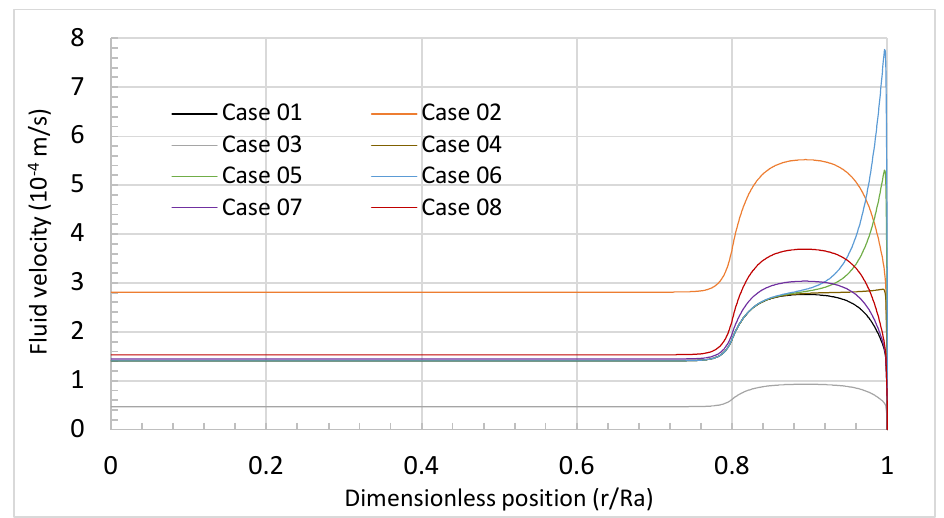
Figure 10. Velocity profiles in a porous cylindrical channel. Double material. Table 6. Flow per unit section in a double-material porous cylindrical channel.